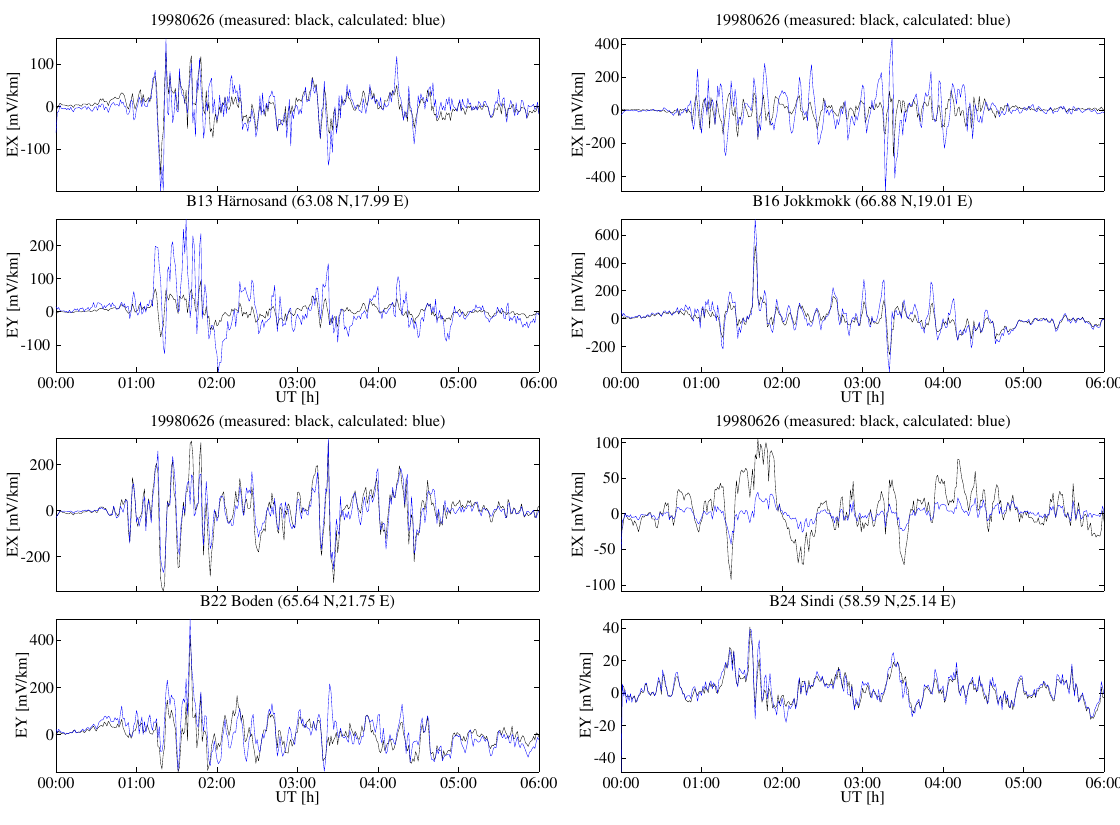
Fig. 5. Measured (black line) and modelled (blue line) electric field at four BEAR sites on 26 June 1998. The local 1-D method (Eq. 3) with conductivity models of Table 1 were used. Each ( E x ,E y ) pair belongs to the same site named between the panels of E x and E y . Locations of the four sites are shown in Fig. 1. Table 1. Earth conductivity models of selected BEAR sites. Re- sistivities are given in (cid:127)m . Values below 60km are identical at all sites and are shown only in the first